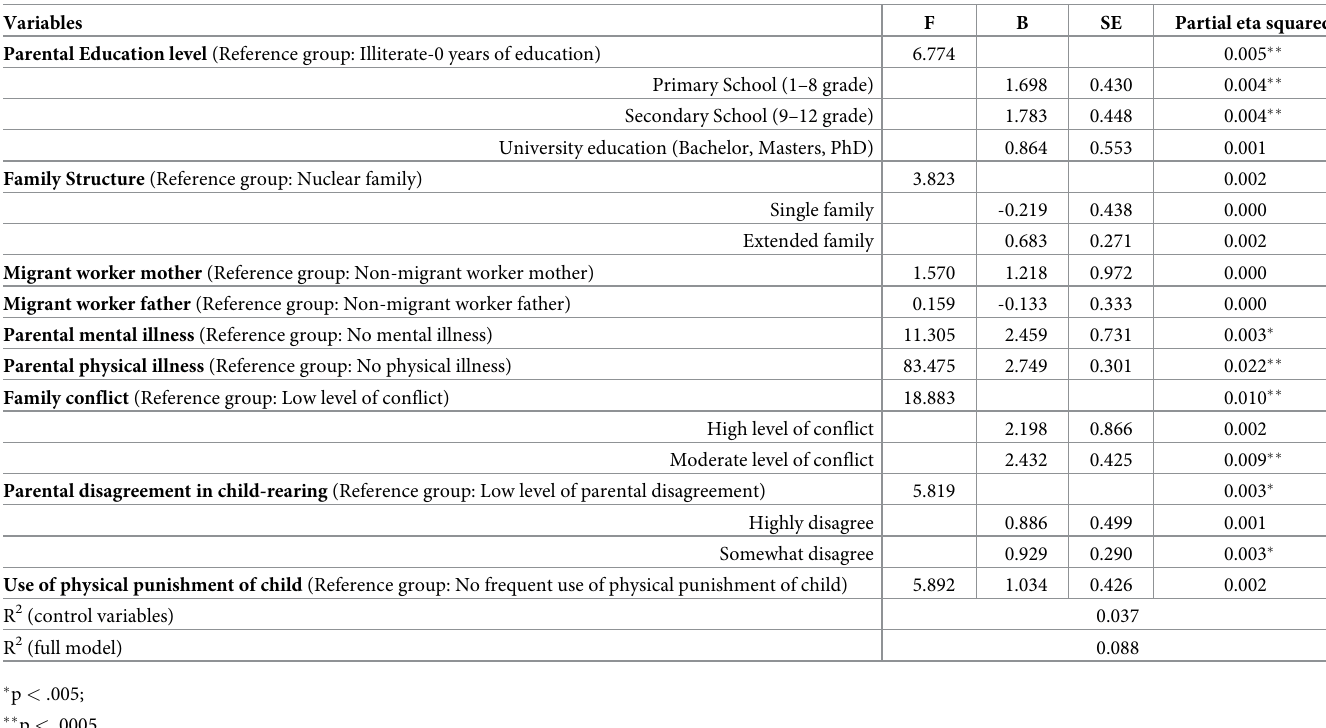
Table 3. Multiple regression analysis of associations between family factors and internalizing